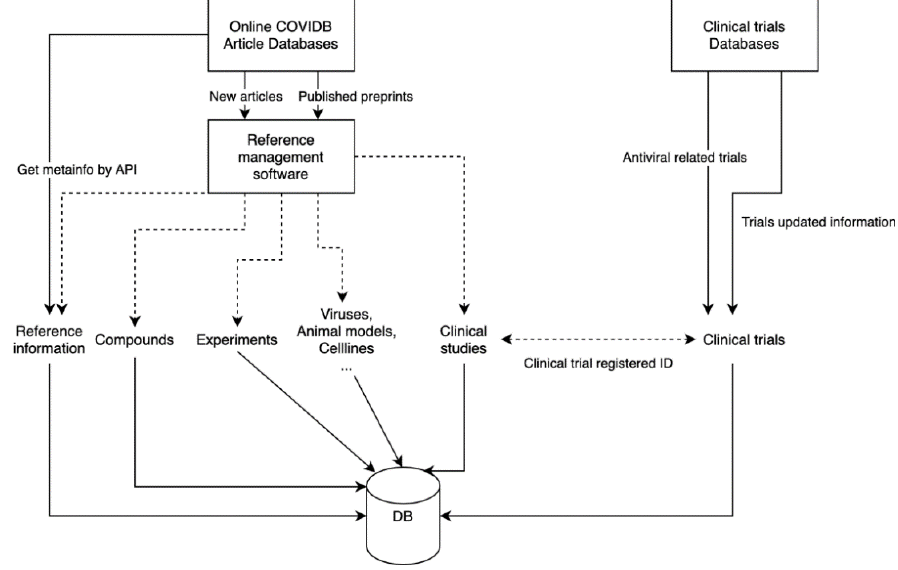
Figure 1. Experiments and clinial trials are semi-automatically downloaded and processed, data are periodically